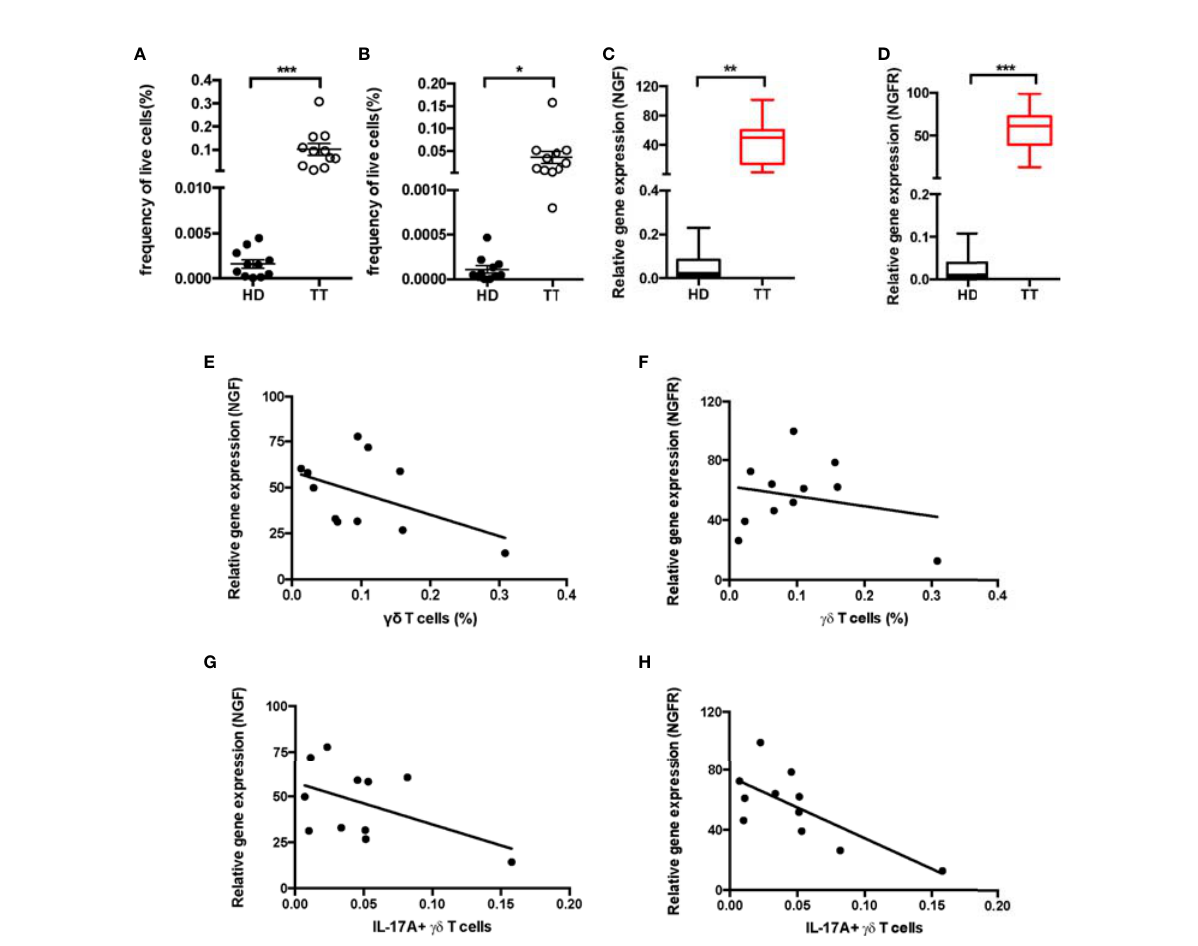
FIGURE 3 Correlation analysis between IL-17A + gd T cells and NGF, NGFR in leprosy lesion. Quanti fi cation of gd T cells (A) and IL-17A + TCR d < sp > +</ sp > cells (B) in dermis from 11 patients and 11 healthy donors. Expression of NGF (C) and NGFR (D) mRNA measured by qPCR in leprosy lesions or healthy skin. Correlation analysis between fraction of dermal gd T cells and NGF (E) and NGFR (F) expression or fraction of dermal IL-17A + TCR d + cells and NGF (G) and NGFR (H) expression. Percentage was shown as mean ± SEM. Statistical analysis was performed by t - test. * p < 0.05; ** p < 0.01; *** p <